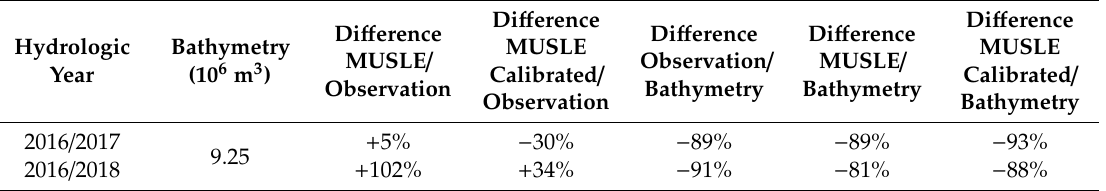
Table 20. Comparison of observation results, application of the calibrated MUSLE, MUSLE_ model, and bathymetry for the four sub-basins of the Bouregreg during 2016 / 2017 and 2017 /